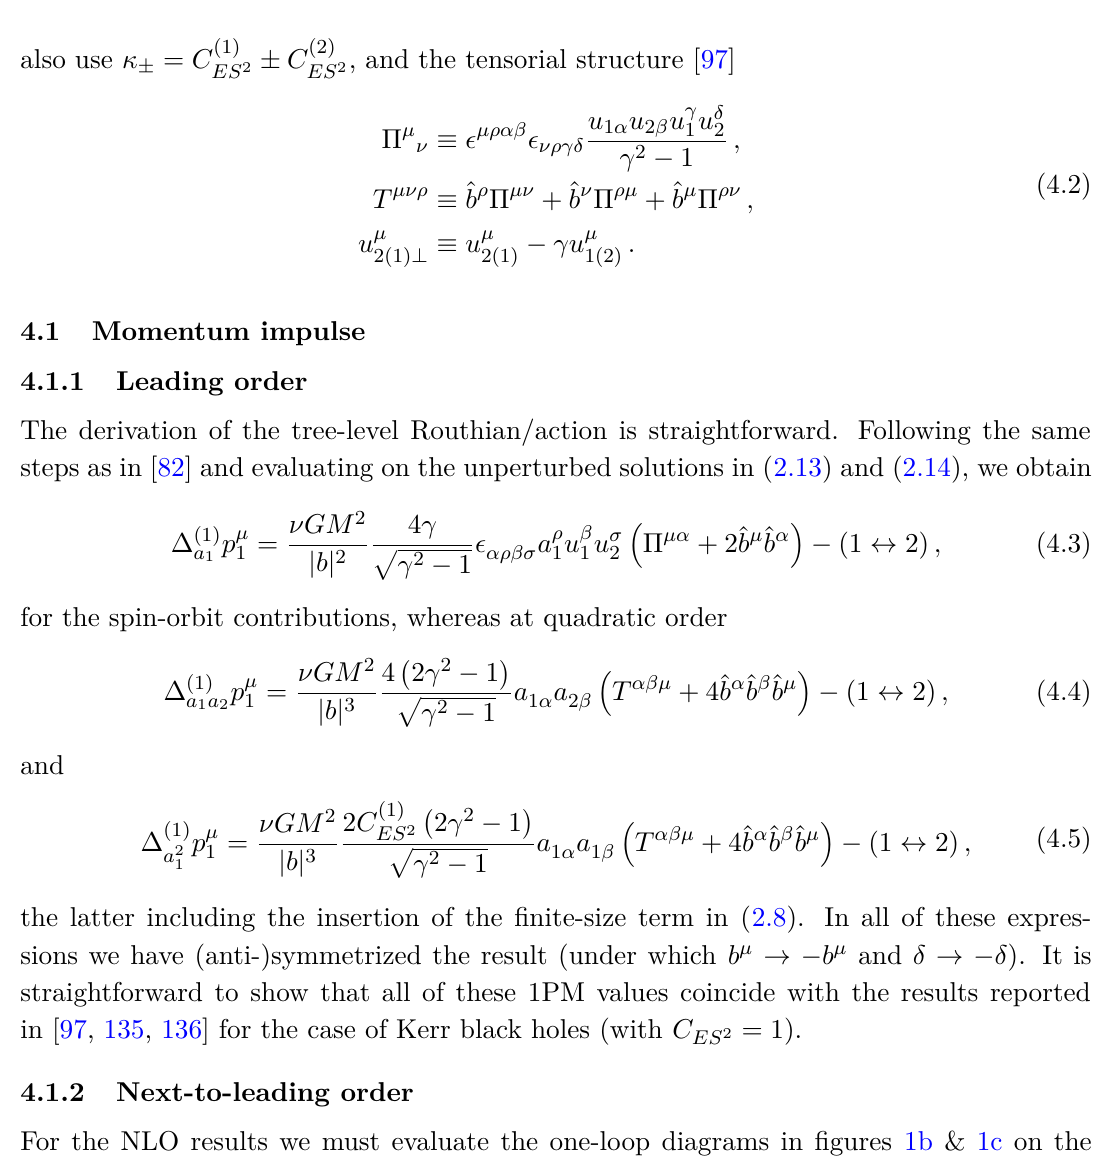
Figure 1. Feynman topologies needed to 2PM order. (See